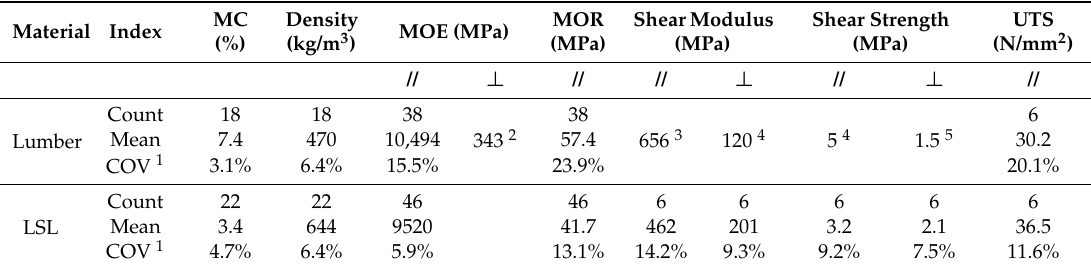
Table 1. Summary of the material properties of lumber and LSL.